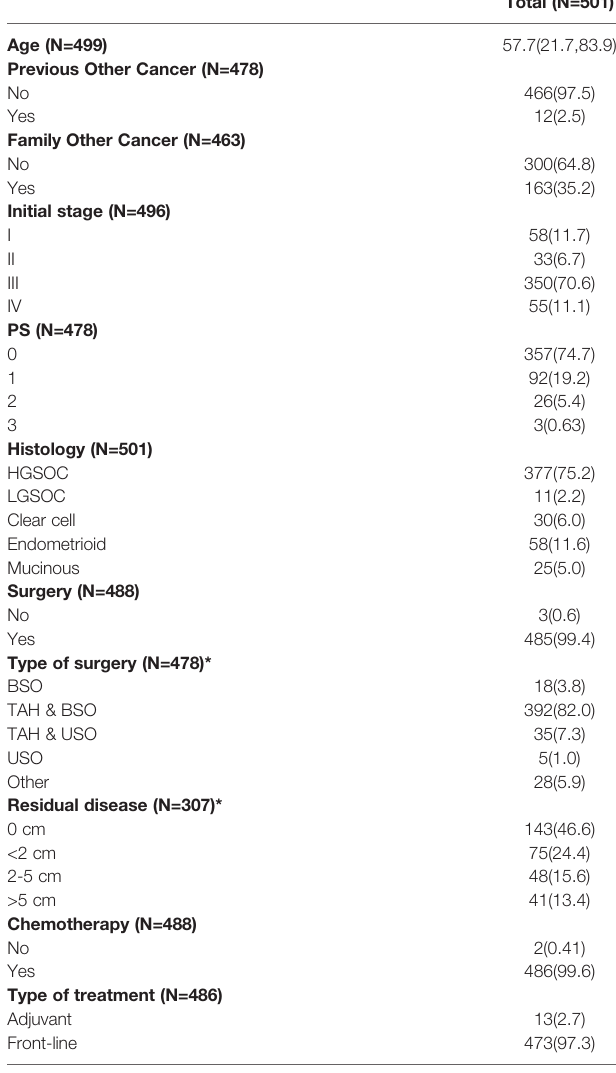
TABLE 1 | Patient and tumor